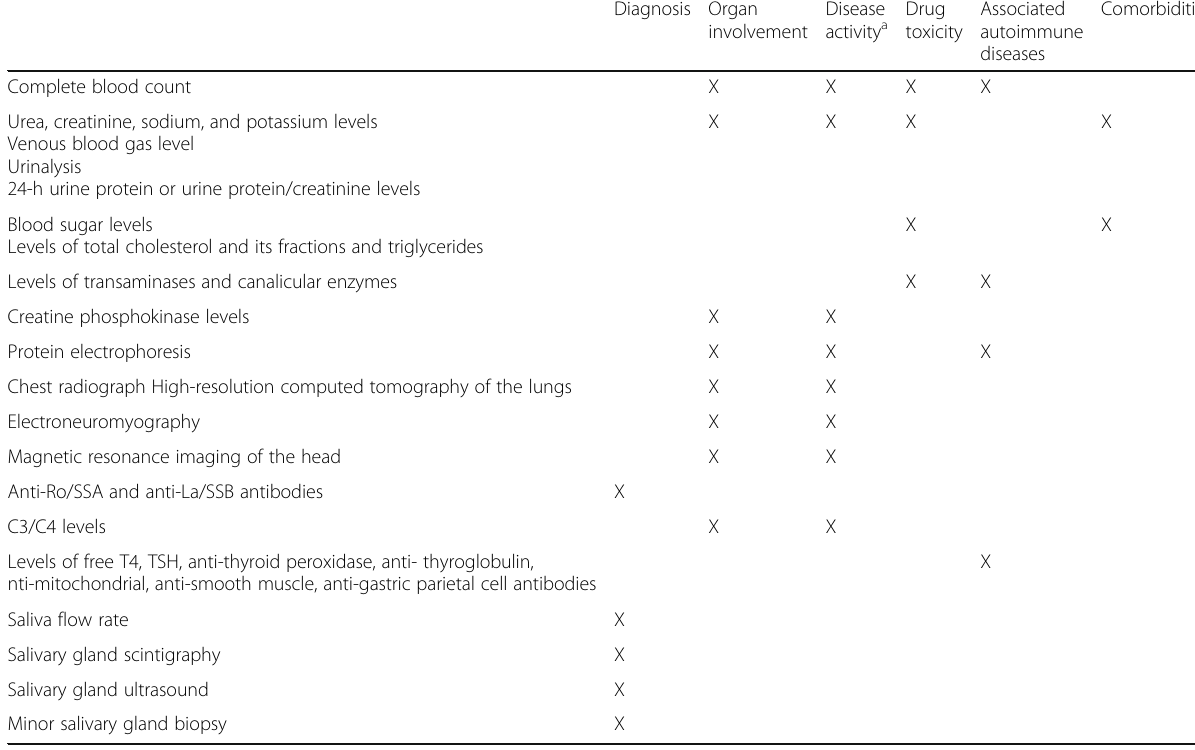
Table 6 Main diagnostic tests for the assessment of patients with primary Sjögren ’ s